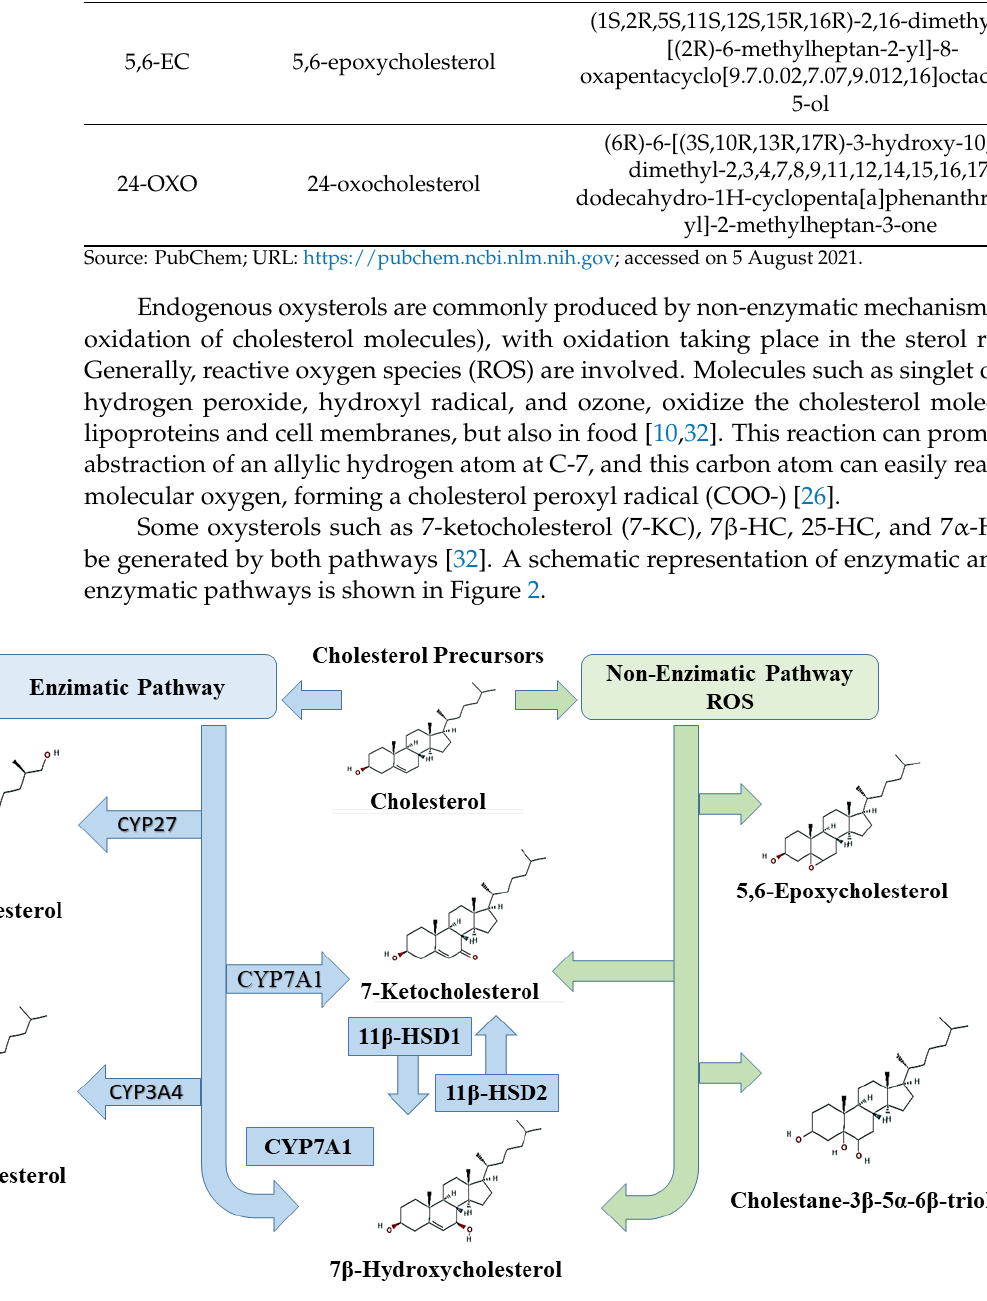
Figure 2. Schematic representation of synthesis of some oxysterols via enzymatic and non-enzymatic pathways. Oxysterols can also be formed in food during heating or prolonged storage of cholesterol-containing products. High oxysterol levels can be found in several foods, such as powdered milk, cheese, egg products, and meat. Some oxysterols can also be formed from cholesterol in the stomach where all the conditions are in place to promote cholesterol oxidation: the acidic pH, and the presence of oxygen, iron ions, or metmyoglobin from dietary origin,